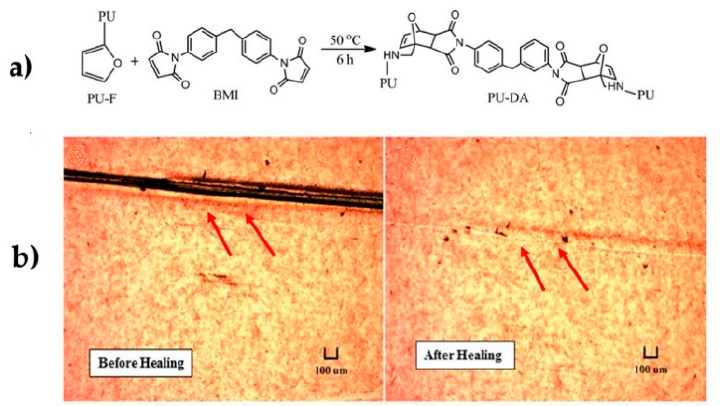
illustrated by optical images of the electrode [90]. Adapted with permission from Tiwari, N;